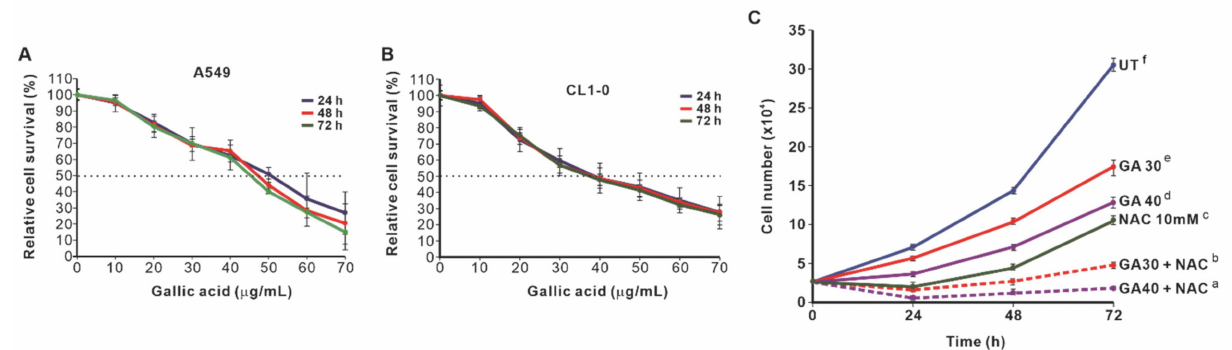
Figure 2. The effects of GA and NAC treatment on the inhibition of cell survival and proliferation of lung cancer cells. A549 cells ( A ) and CL1-0 cells ( B ) were treated with different concentrations of GA (0, 10, 20, 30, 40, 50, 60, 70 µ g/mL) for 24, 48 and 72 h of treatment. The cell survival rate of a concentration of GA cultured for 24 h (SR 24,[GA] ) was calculated by dividing the number of cells in each GA treated group for 24 h (N 24,[GA] ) by the cell number of the untreated group for 24 h (N 24,[GA]=0 ). The relative survival rate of the untreated group for each incubation time was defined as 100%. ( C ) NAC (10 mM) enhanced GA-induced inhibition of A549 cell proliferation. One-way ANOVA and the Scheff é test were used for analysis of NAC and NAC/GA treatment groups; F(5,12) = 1077.164, p = 1.76 × 10 − 15 . The letters in the figure indicate the homogeneous subsets, and data sharing the same letter are not significantly different as determined by the Scheff é test ( p > 0.05). GA30 (30 µ g/mL), GA40 (40 µ g/mL).